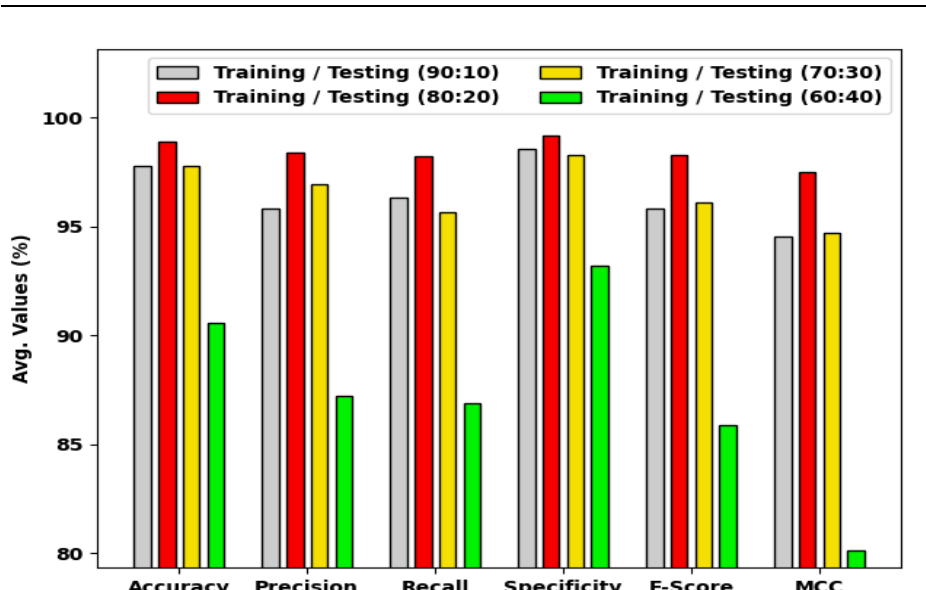
Figure 5. Analysis results of the CSO-CADLCC technique under distinct classes and TR/TS